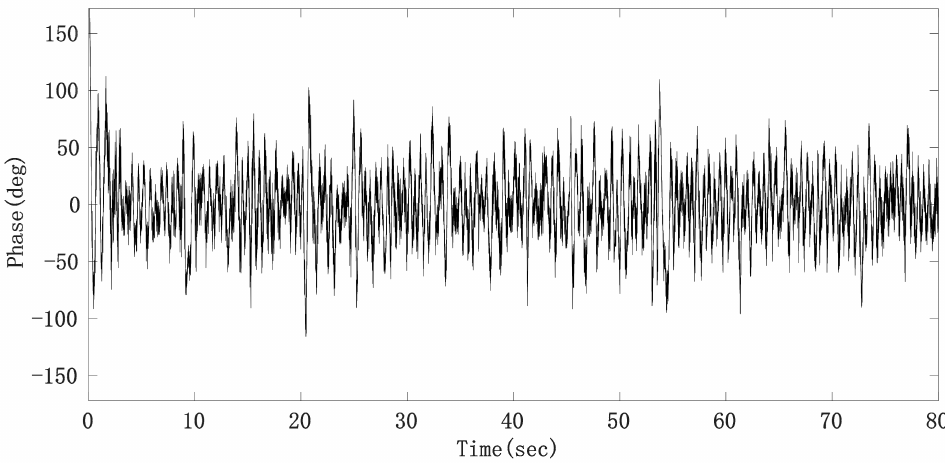
Figure 14. Phase sequence data after removing respiratory fundamental wave.